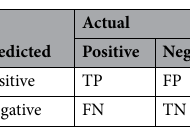
Table 1. Confusion